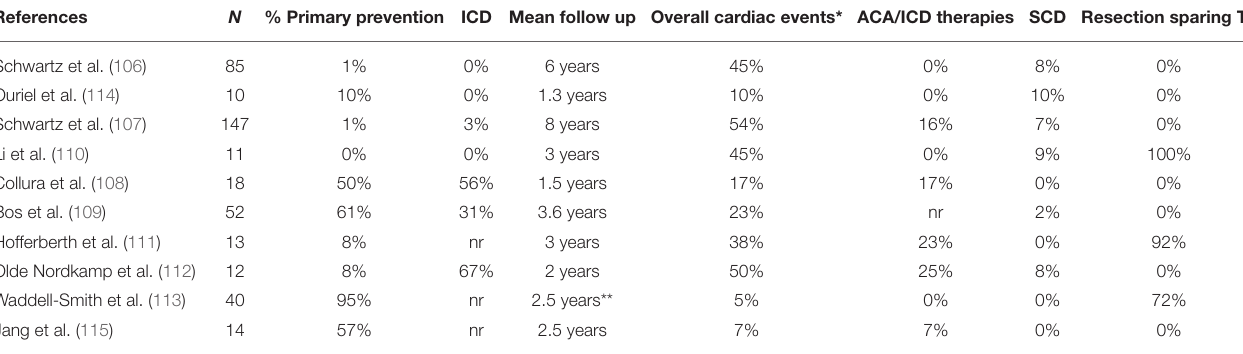
TABLE 1 | Largest case series reported of LCSD in LQTS (at least 10 patients with at least 1 year of follow